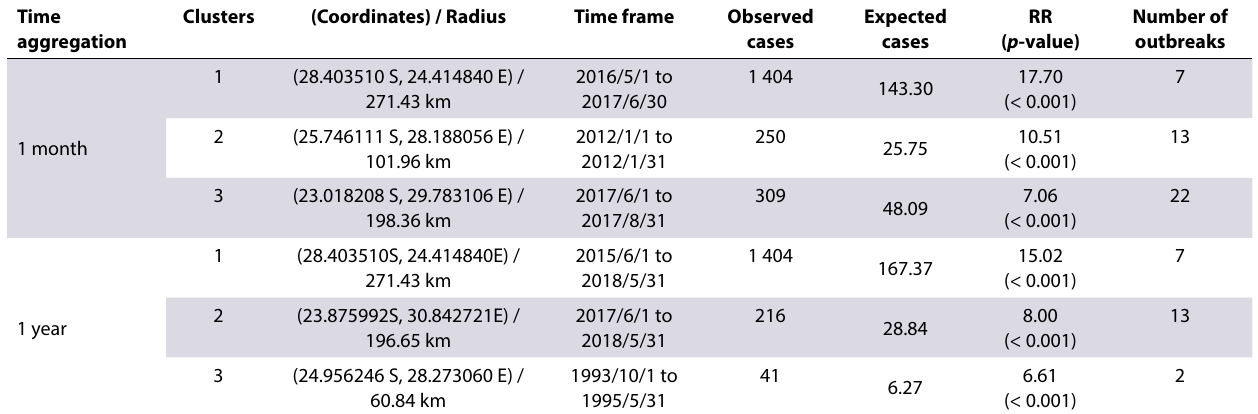
Table I: Summary of spatiotemporal clusters analysis of ASF in South Africa Time Clusters (Coordinates) / Radius Time aggregation